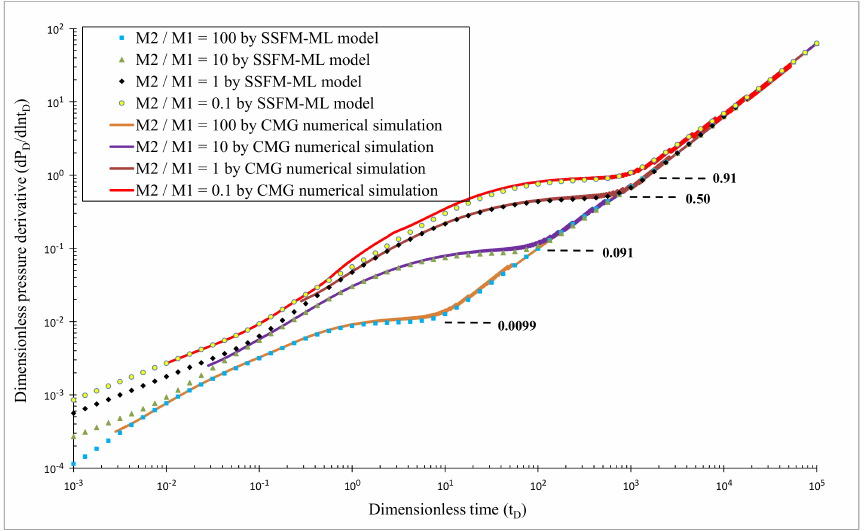
Figure 8. Dimensionless pressure derivative response of MHFHW with N stage = 10 in a 2-layer reservoir under various M 2 /M 1 ratios with fractures near-fully penetrating reservoir width as 2 L f 1 D = 2 L f 2 D = 0.98. Fracture height is set to be small in order for pseudo-radial to be evolved x e 1 D = x e 2 D with h f 1 D = h f 2 D = 5; x e 1 D = x e 2 D = 100, y e 1 D = y e 2 D = 100, h e 1 D = h e 2 D = 50 and C s2 /C s1 = 1. Solutions from commercial numerical simulation software CMG are also provided for comparison (curves). They both have the same reservoir-well system geometry and reservoir